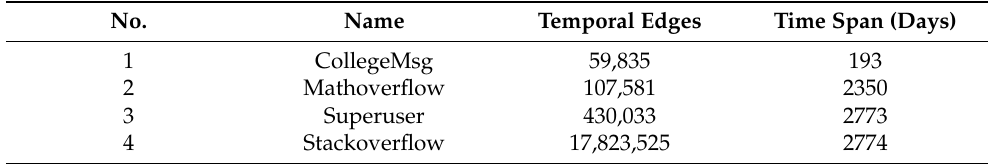
Table 1. Dataset